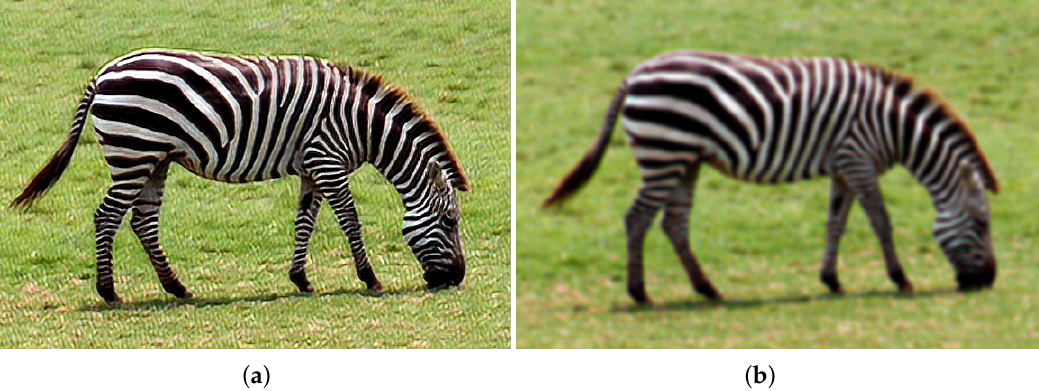
Figure 4. Quantization SRCNN: ( a ) Post-Training Quantization; ( b ) Quantization Aware